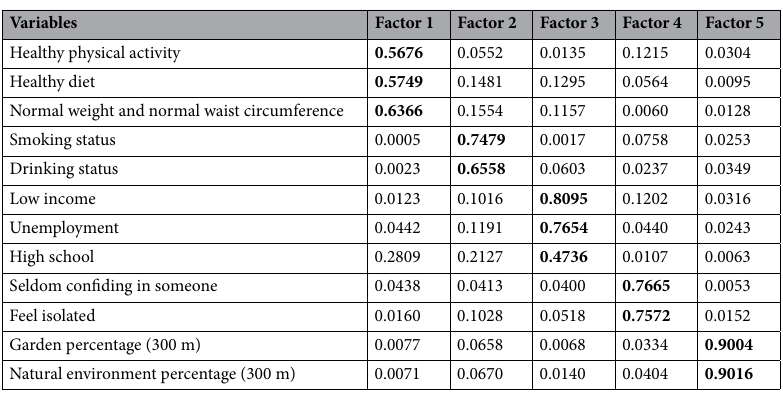
Table 1. Matrix of factors (absolute value). Significant values (loadings over 0.4) are in [bold].